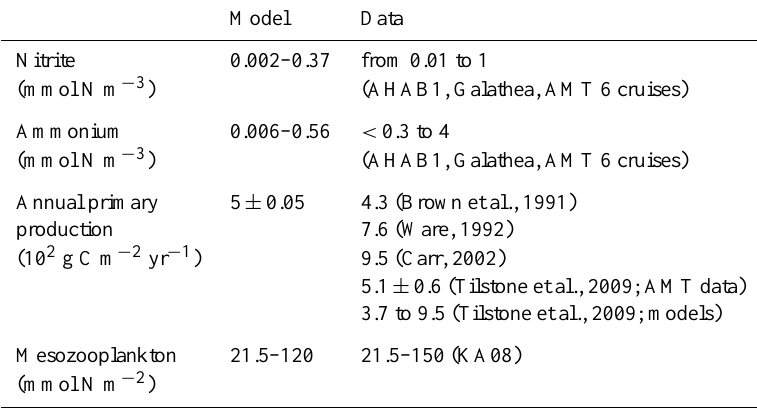
Table 1. Summary of comparison between simulated and in situ data for nitrite, ammonium, primary production (integrated over the euphotic zone), and zooplankton (time series at 23 ◦ S integrated over 200m